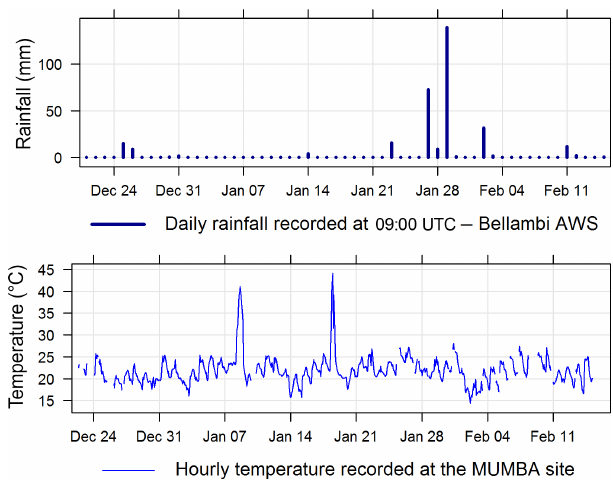
Figure 2. The upper panel shows a bar chart of daily rainfall in millimetres from Bellambi AWS. The lower panel shows the time series of the mean hourly temperature measured during